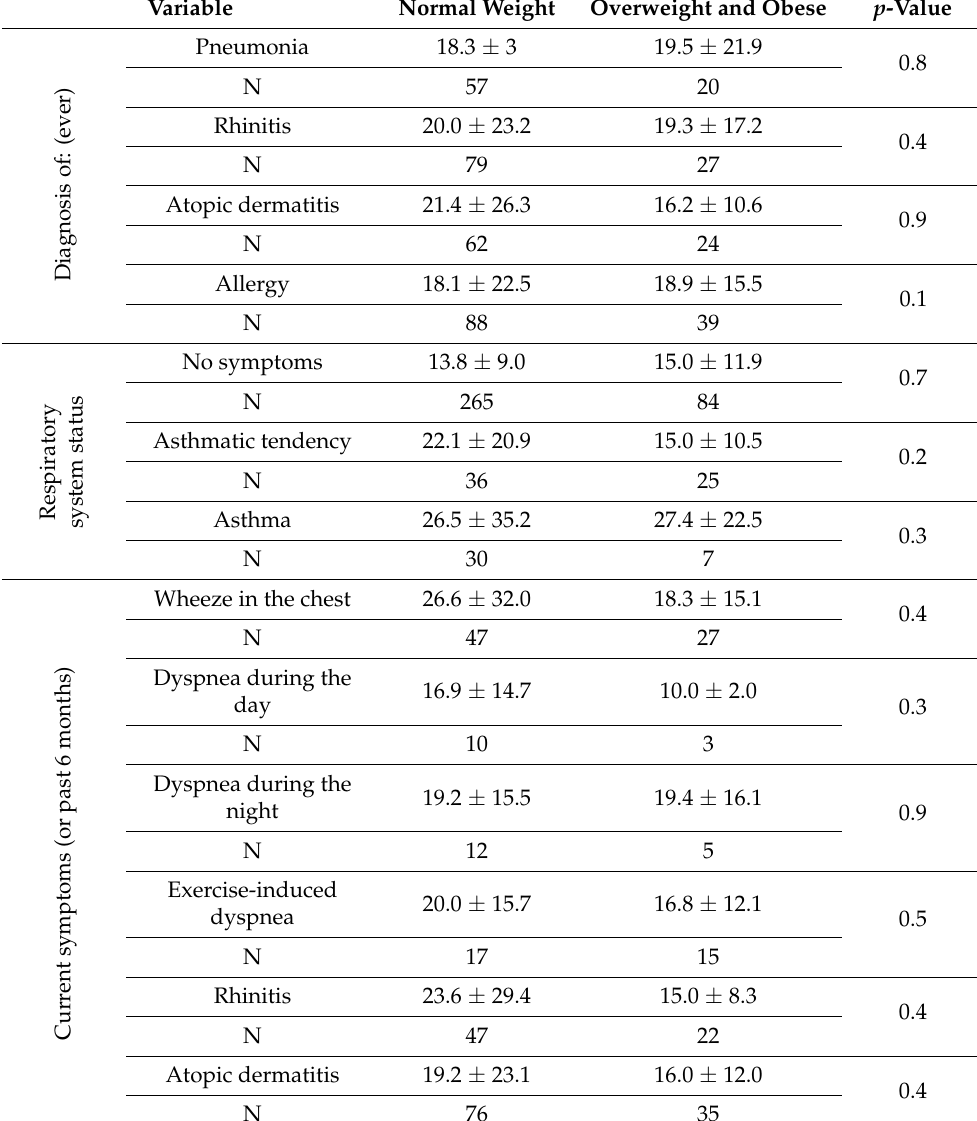
Table 3. FeNO levels according to diagnosis and symptoms from respiratory system in children. Variable Normal Weight Overweight and